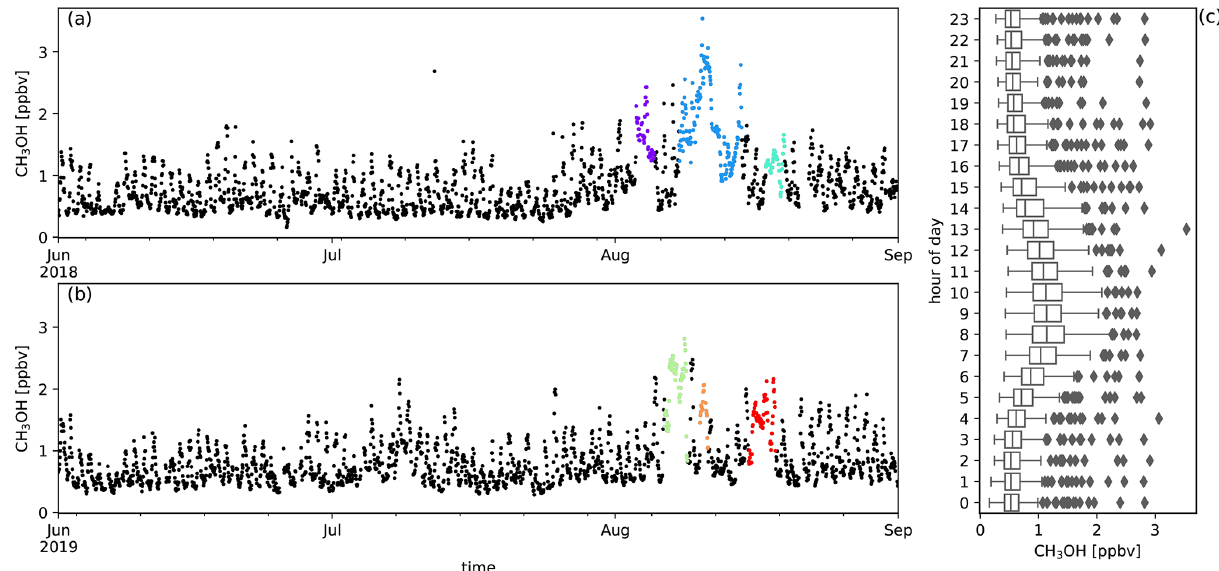
Figure A8. Measured CH 3 OH mixing ratios (ppbv) during austral winter 2018 (a) and austral winter 2019 (b) together with the diel distri- bution of hourly averages (c) . Biomass burning plumes under investigation are highlighted in colours.